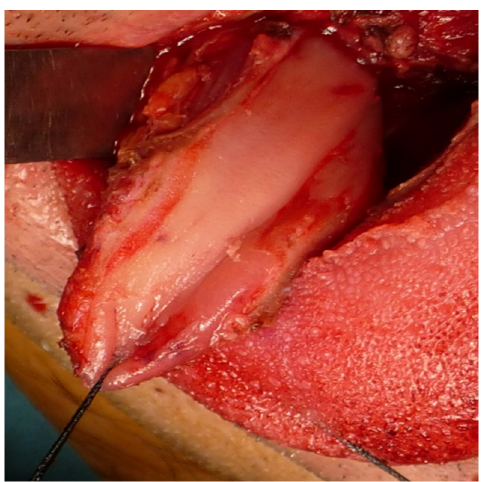
Figure 4. Immediate reconstruction of tongue and floor of the mouth defect.